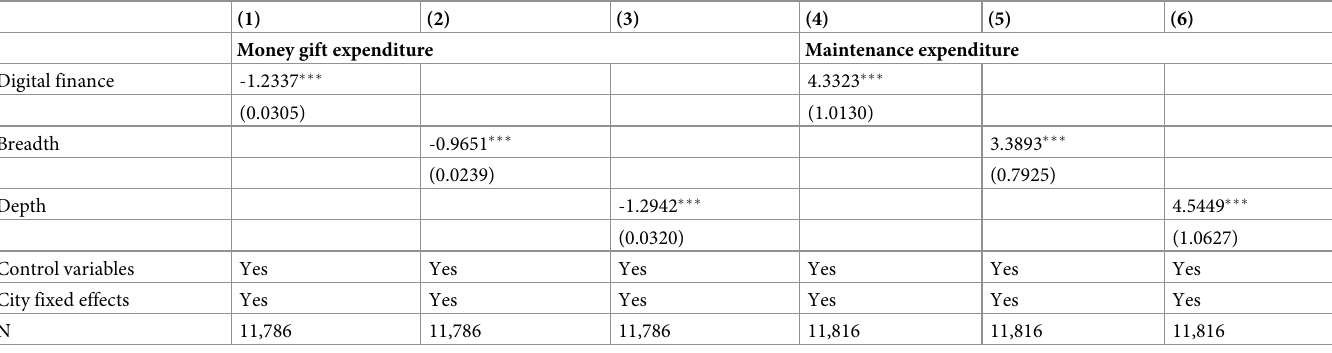
Table 10. Digital finance and expenses related to social networks.